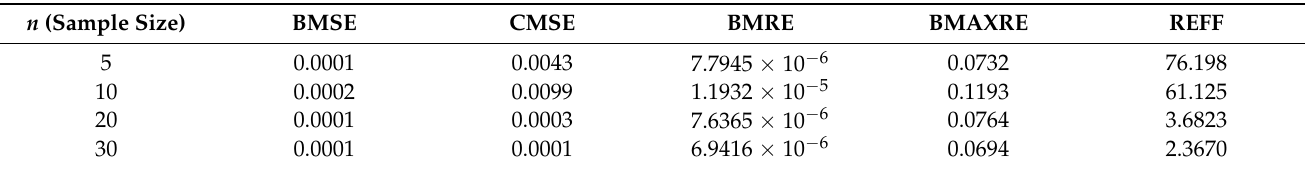
Table 6. Estimation efficiency: numerical results for case